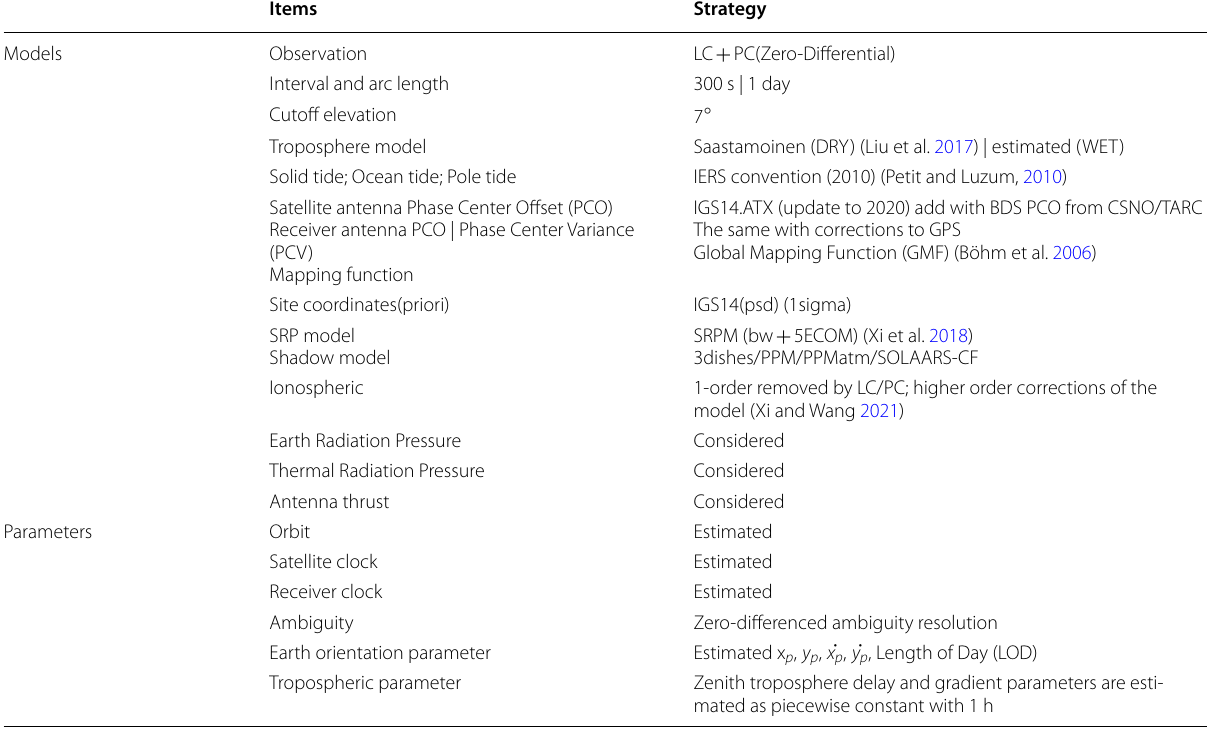
Table 2 Correction models and parameter estimation strategy